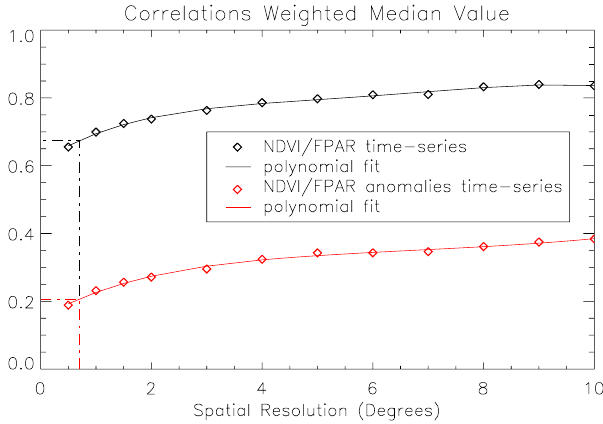
Fig. 9. Surface-weighted median values for the NDVI/FPAR time series (thick black diamonds) and anomaly time series correlations (thick red diamonds), as a function of the spatial resolution. The black and red curves are the results of degree 5 polynomial fit. The dashed lines indicate the extrapolation to the theoretical resolution of 0.7 ◦ using the polynomial